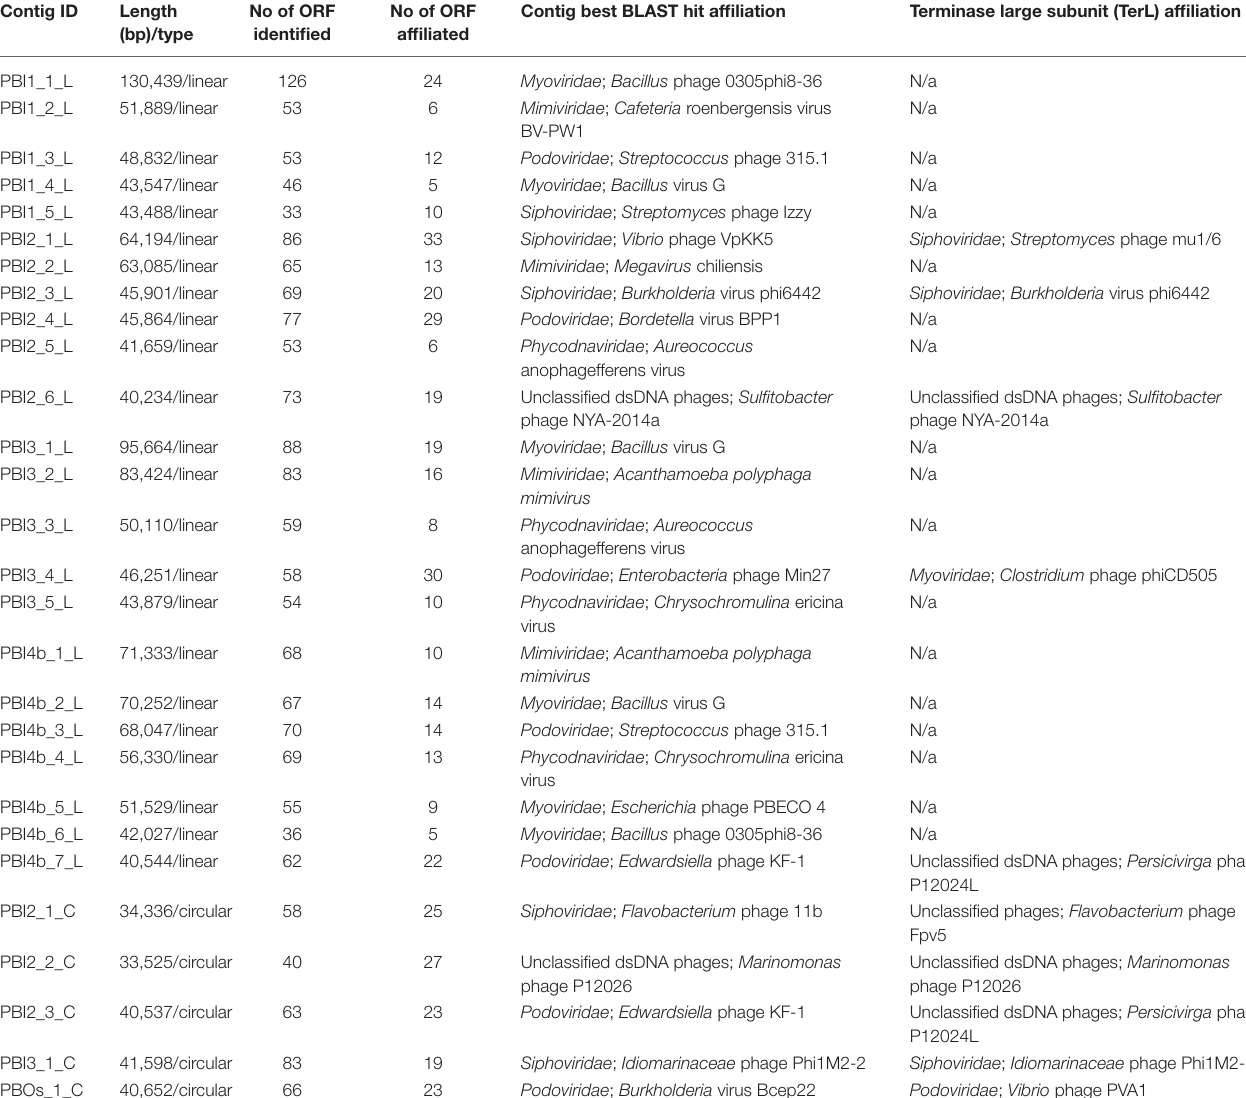
TABLE 3 | Analysis of selected contigs in the Prydz Bay viromes. Contig ID Contig best BLAST hit